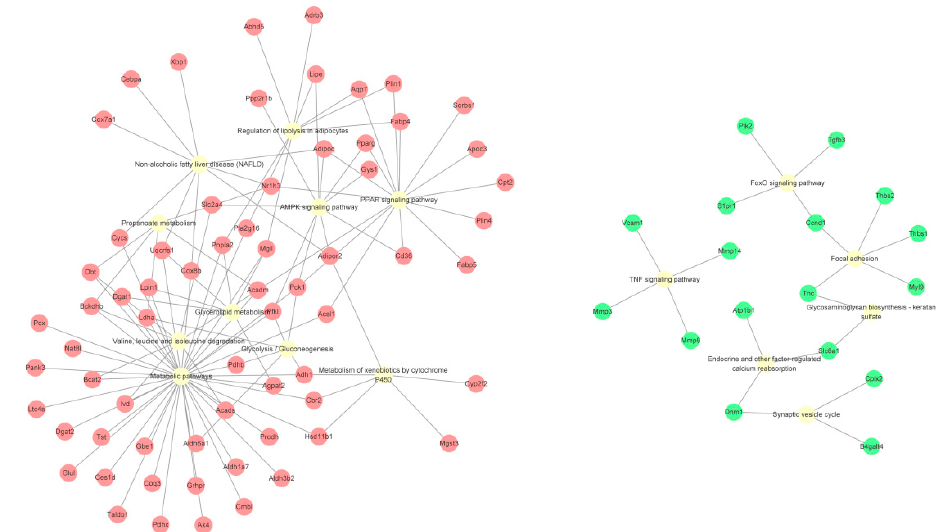
Figure 4. Distribution of up- and down-regulated genes associated with adipogenesis in different KEGG pathways. The upregulated genes (red), downregulated genes (green), and pathway nodes (yellow) are represented by circles. Table 4. Kyoto Encyclopedia of Genes and Genomes (KEGG) pathway enrichment analysis of DEGs in adipogenesis.